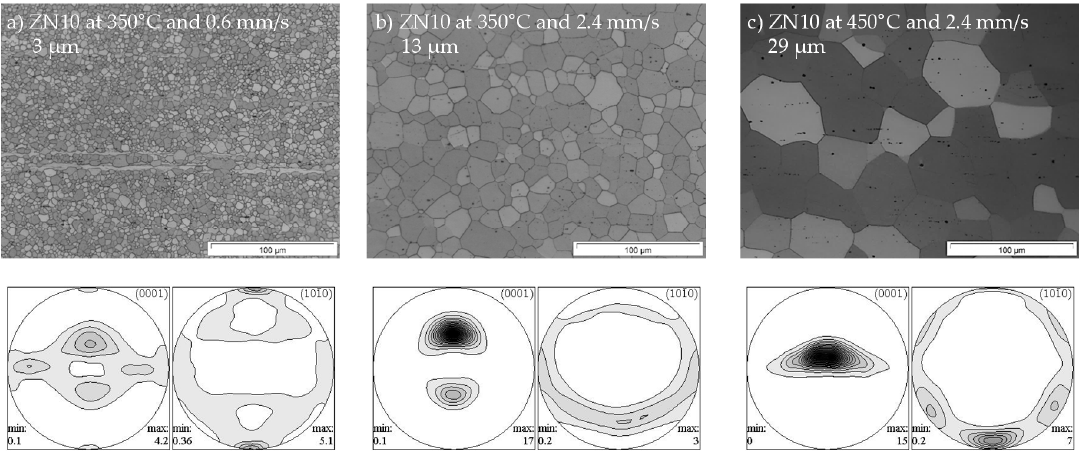
Figure 7. Microstructure and texture of extruded flat bands of alloy ZN10 with varied extrusion temperatures and extrusion rates (ram speed): ( a ) 350 °C and 0.6 mm/s (average grain size: 3 µm); ( b ) 350 °C and 2.4 mm/s (average grain size: 13 µm); ( c ) 450 °C and 2.4 mm/s (average grain size: 29 µm), legends as in Figures 1 and 2.